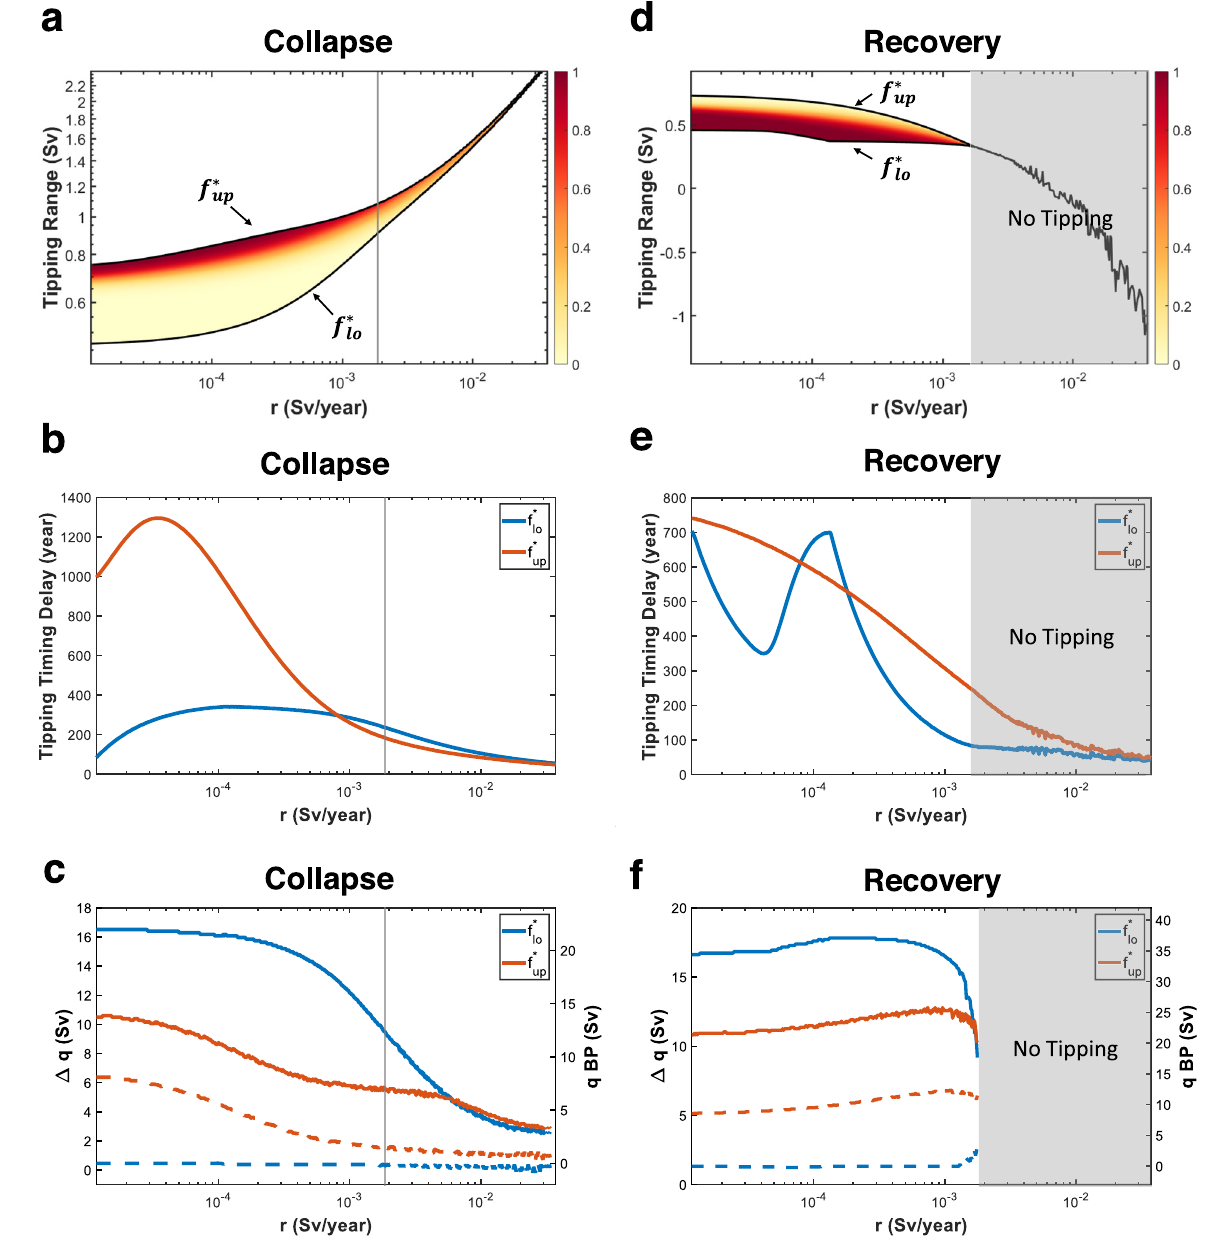
Fig. 3 The tipping modulation experiment with varying freshwater forcing rate using Stommel ’ s model. a A tipping range is plotted with (lower black line) and f (cid:4) (upper black line). The red color denotes p SA , the probability for being in the tipped state. b A its boundaries, f (cid:4) lo up tipping timing delay for f (cid:4) (blue line) and f (cid:4) (orange line). The time unit is years. c The left axis denotes difference of y at the tipping range lo up boundaries, Δ y (cid:4) (blue thick line) and Δ y (cid:4) (orange thick line). The right axis denotes y values at the tipping range boundaries, y (cid:4) up lo line) and y (cid:4) (orange dashed line). On the collapse case, a , b and c , the thin gray line is shown at r = 0.5 (approximately 1 : 9 ´ 10 (cid:5) 3 Sv = year ). The up cases shown in Fig. 2d, e, and f are the same as those shown in a , b , and c , respectively, but for the recovery